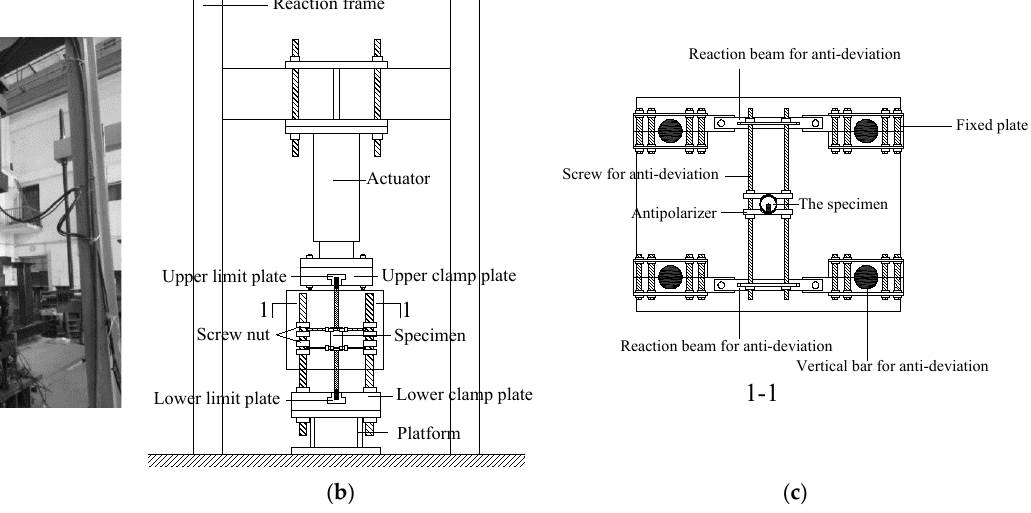
Figure 8. Repeated tension and compression loading equipment: ( a ) setup of the test, ( b ) schematic diagram of the anti-deflection device, and ( c ) Section 1-1.